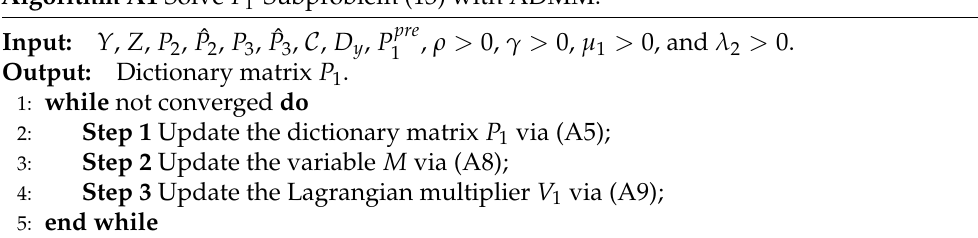
Algorithm A1 Solve P 1 -Subproblem (13) with